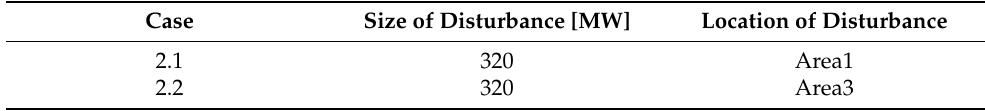
Table 4. Simulation data for determining the impact of inertia